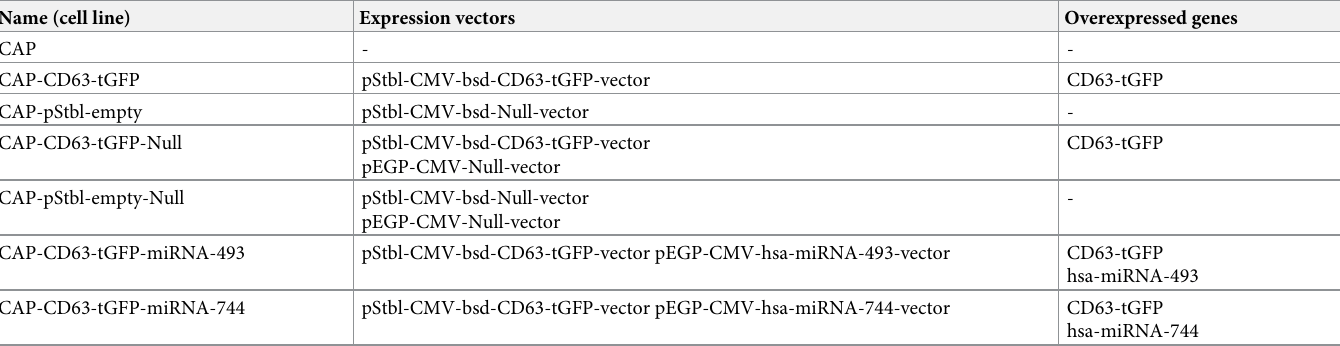
Table 1. Engineered CAP 1 cell lines for the analysis of